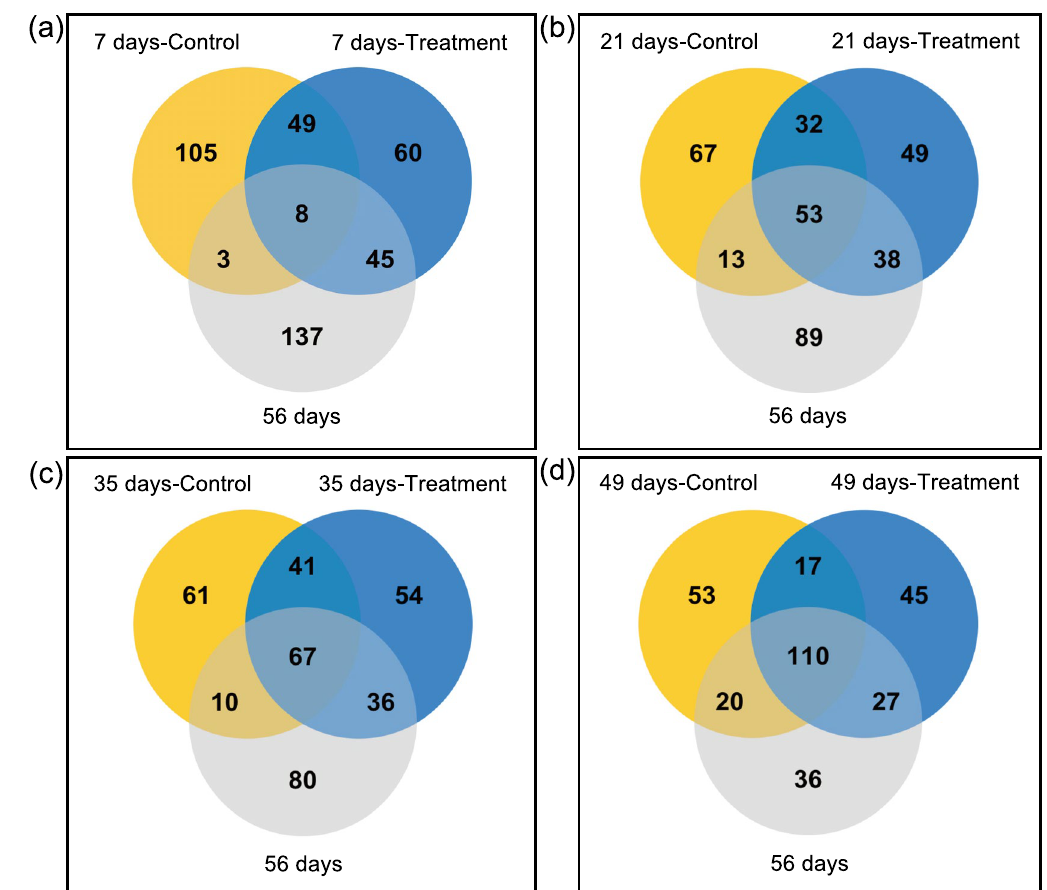
Figure 2. Bacterial ASVs shared by pre-weaned and weaned calves. Venn diagrams of ASVs shared by pre- weaned calves at ( a ) 7, ( b ) 21, ( c ) 35, and ( d ) 49 days of age and weaned calves at 56 days of age are shown. Pre- weaned calves were separated based on the dietary